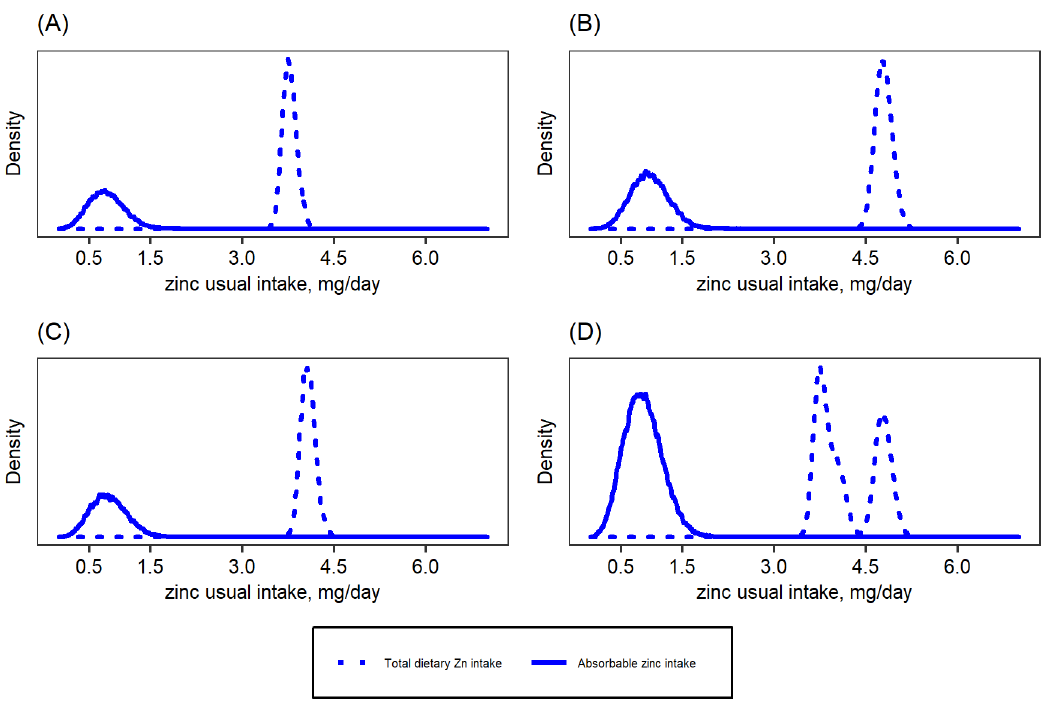
Figure 1. Total dietary and absorbable zinc intake distributions for children aged 12–59 months in Cameroon: (A) South macro ‐ region, (B) North macro ‐ region, (C) Yaoundé/Douala, (D) National. Absorbable zinc intake was estimated based on Miller’s equation [24].